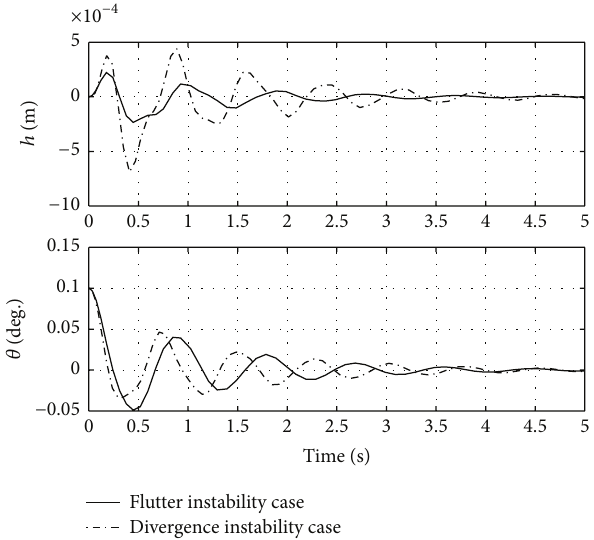
Figure 6: Responses of plunge displacement and torsional deflec- tion with microtab control for flutter instability and divergence instability